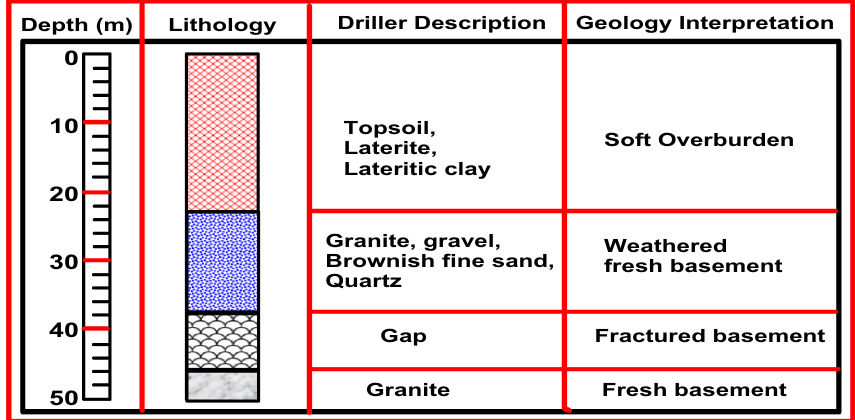
Fig. 4 Geological well-logs (borehole) data around the study area modelled after